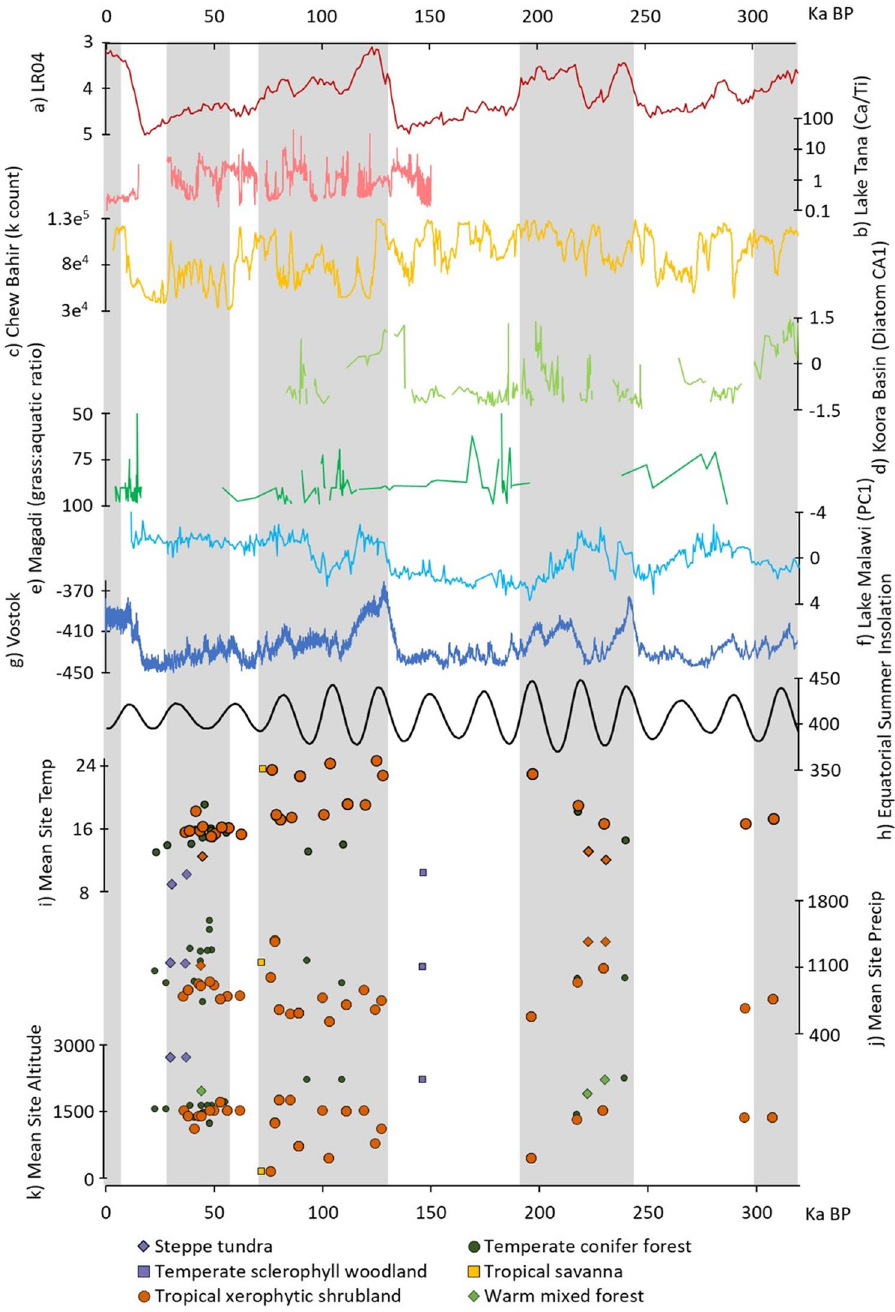
Figure 1. Composite of key inter-regional and regional climatic records, insolation, and temperature, precipitation and altitude parameters for dated eastern African Middle Stone Age occupations including ( a ) LR04 Benthic Stack δ 18 O 25 ; ( b ) Lake Tana Ca/Ti ratio 19 ; ( c ) Chew Bahir k-counts 26 ; ( d ) Koora Basin diatom CA 20 ; ( e ) Magadi Pollen grass:aquatic ratio 27 ; ( f ) Lake Malawi PC1 28 ; ( g ) Vostok δD [‰ SMOW] 29 ; ( h ) mean Equatorial summer (Jun-Aug) insolation (W/m2) 30 ; mean ( i ) temperature (°C), ( j ) precipitation (mm), and ( k ) altitude (meters above sea level) within 50 km radius of eastern African MSA assemblages, illustrated at the mid-age point for each occupation and symbolised according to its biome classification. Grey vertical bars indicate odd-numbered Marine Isotope